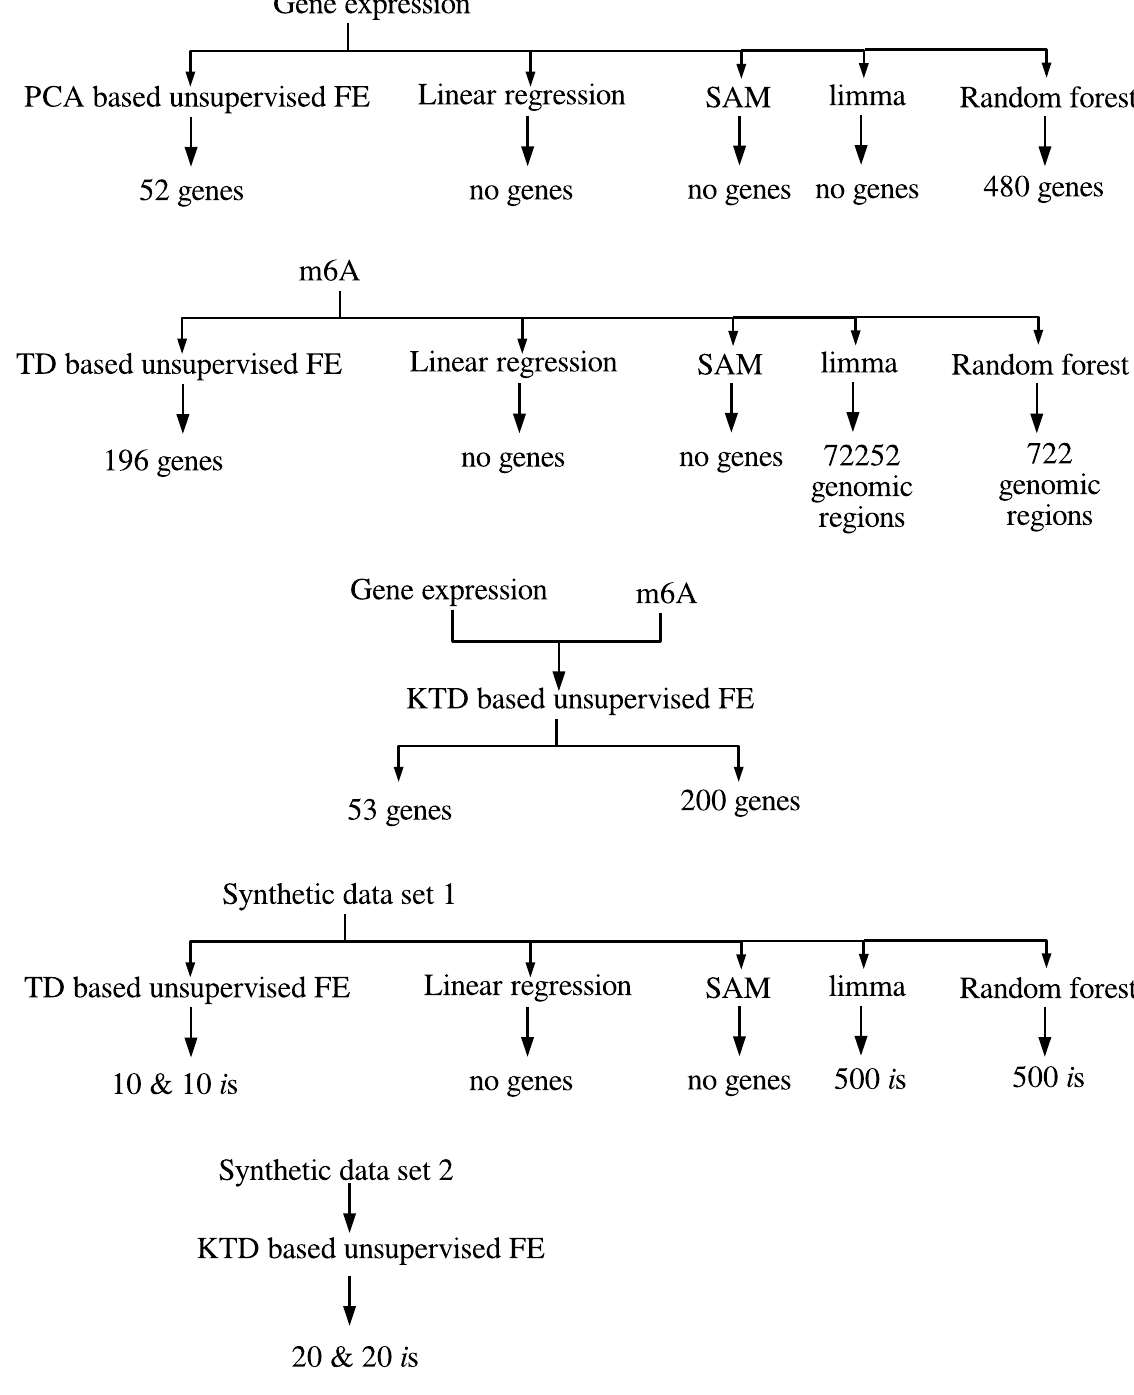
Figure 1. Flow chart of analyses performed in this